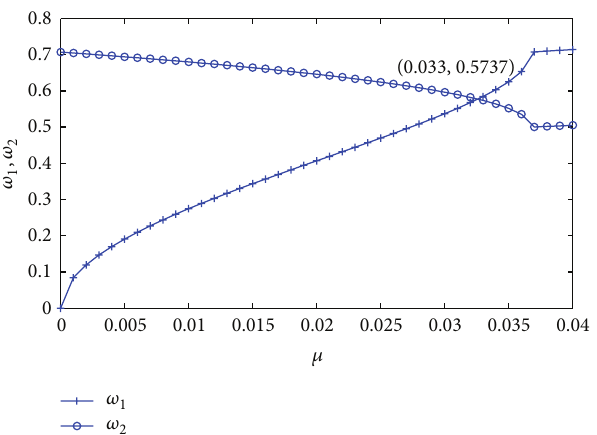
Figure 2: Correlation between 𝜇 and 𝜔 1 and 𝜔 2 with 𝛽 1 = 0.01 , = 0.02 , 𝐴 = 0.0 3, and 𝐴 𝛽 2 1